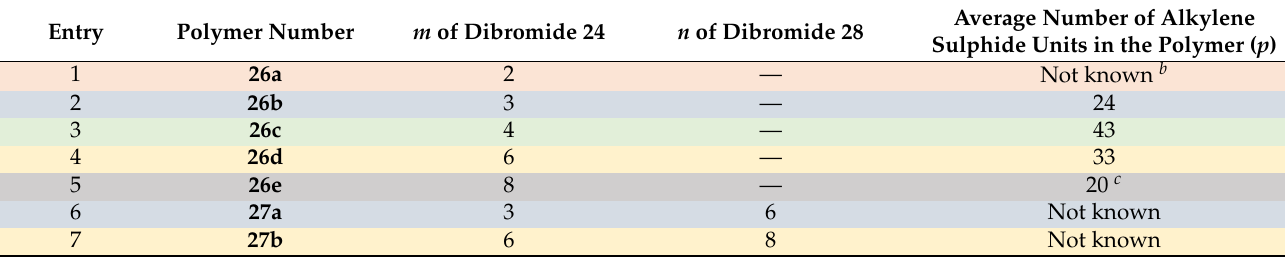
Average Number of Alkylene Sulphide Units in the Polymer ( p